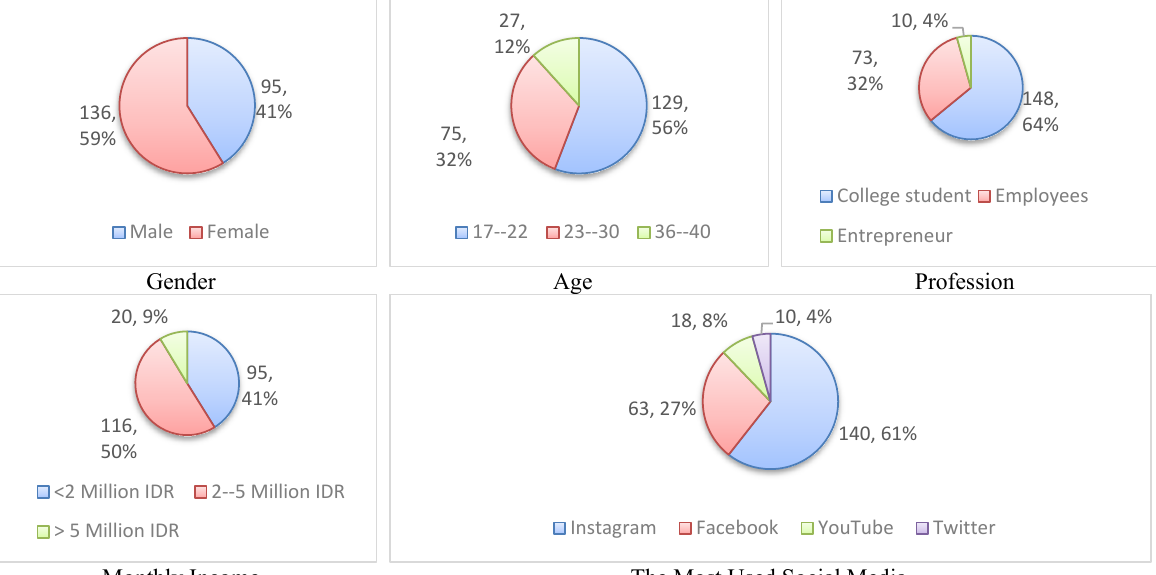
Fig. 3. Characteristics of the